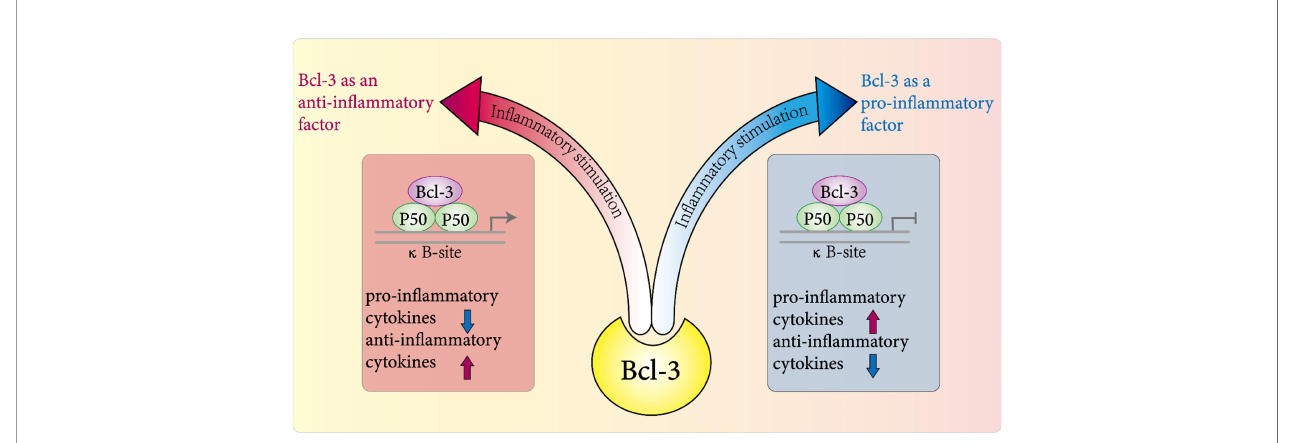
FIGURE 3 | Role of Bcl-3 in in fl ammation. In various disease models, it plays a pro-in fl ammatory or anti-in fl ammatory role directly or indirectly in the host's in fl ammatory response to pathogens by regulating the expression and release of a variety of in fl ammatory